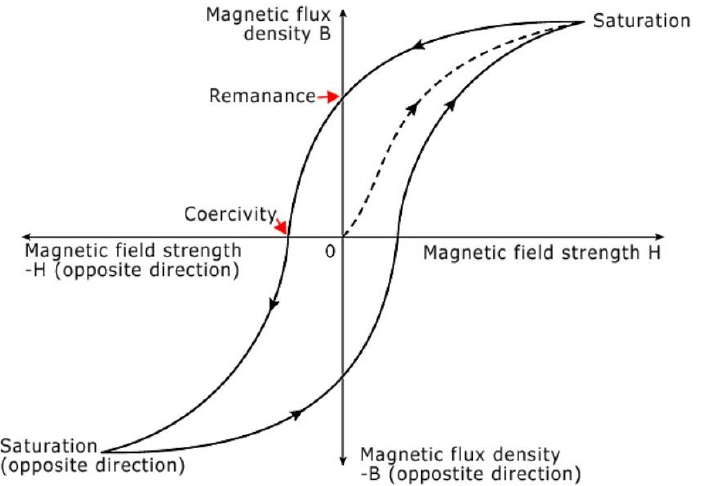
Figure 1. Typical hysteresis loop.